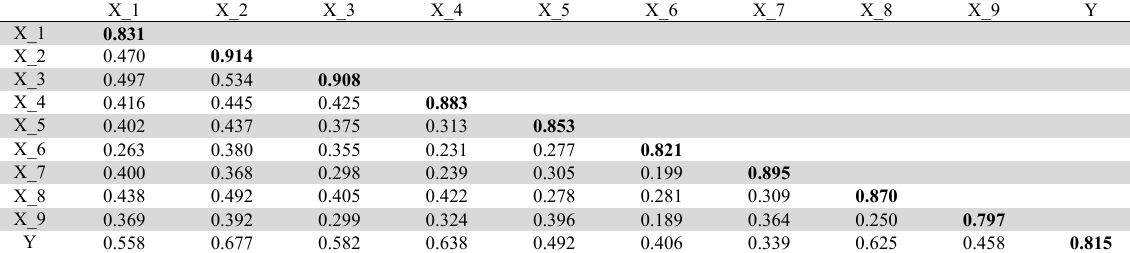
The results of the evaluation of discriminant value by Fornell-Larcker's